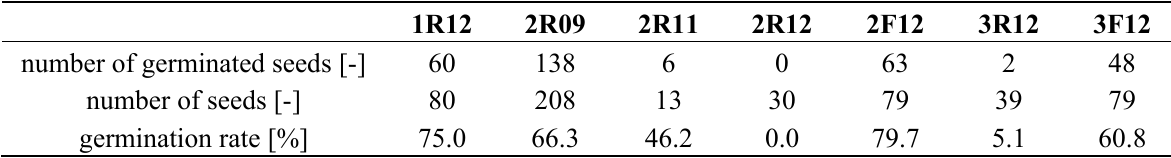
Table 1. Germination rates of 7 different seeds of Jatropha curcas .